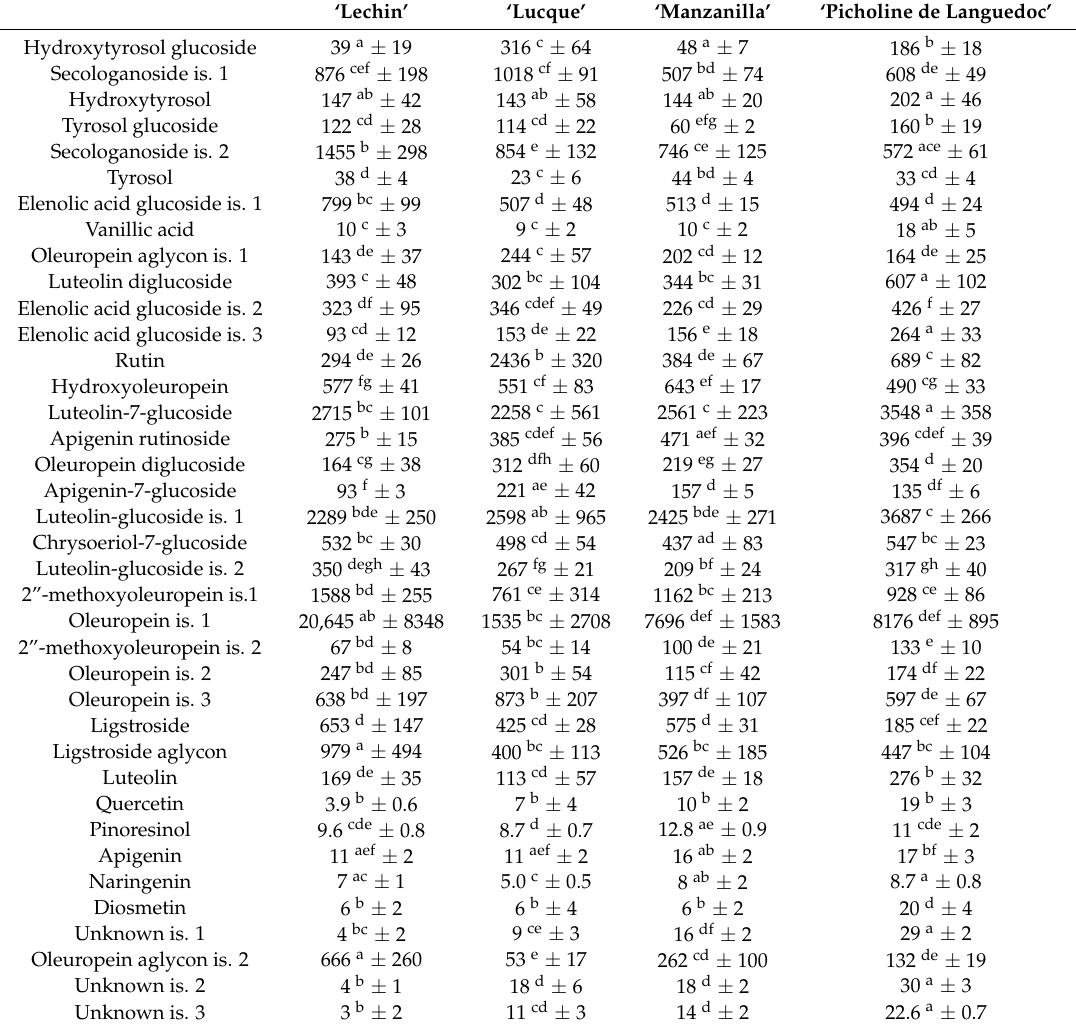
Table 3. Found content (average values and standard deviation, mg/kg DW) of the determined phenolic compounds in the evaluated olive leaves cultivars. ANOVA results are included; significant differences in the same row are indicated with different superscript letters (comparison among the 11 cultivars investigated in this study, p <